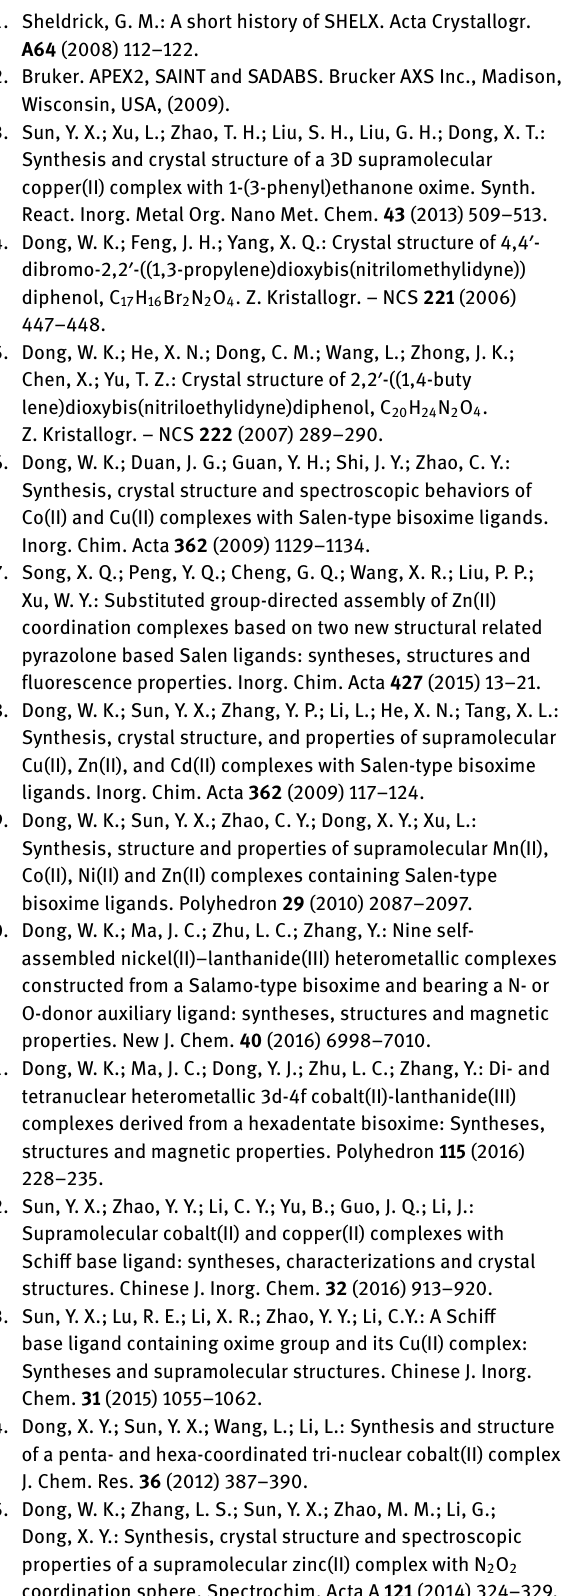
Table 2: Fractional atomic coordinates and isotropic or equivalent isotropic displacement parameters (Å 2